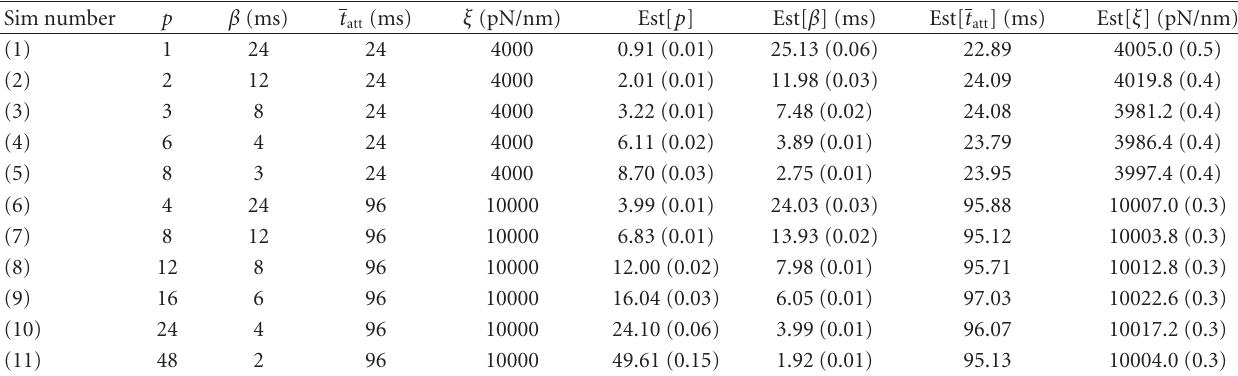
Table 1: Parameter values used to generate random numbers in computer simulations of a force response due to myosin crossbridges subjected to sinusoidal length perturbations, and estimated parameter values from that force response fit to (15). For all simulations t = 1pN/nm. Est[] = estimated value of bracketed parameter, () indicates the ± 95% confidence intervals = 96 ms , N = 20,000 and k det sti ff for estimated value. The correlation between actual and estimated values resulted in a correlation coe ffi cient greater than 0.997 for each